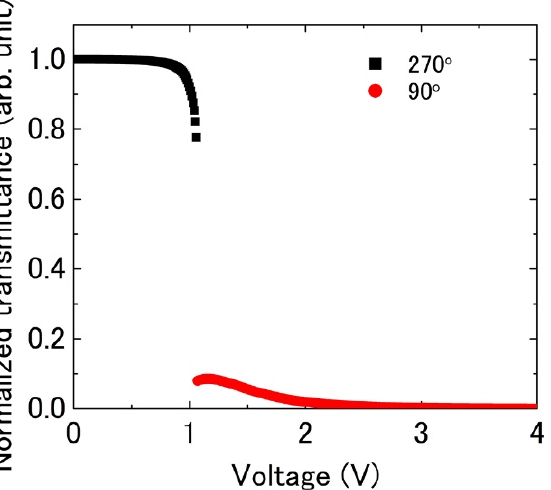
Figure 8. Transmittance as a function of the applied voltage for LPSTN (MLC-2173, chiral pitch 15.0 µm, cell thickness 5.4 µm).